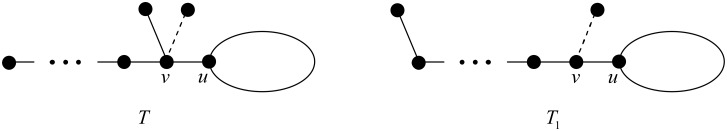
The chemical trees T and T1 in Lemma 2.(The edges which are represented by dashed lines may or may not occur in the tree).